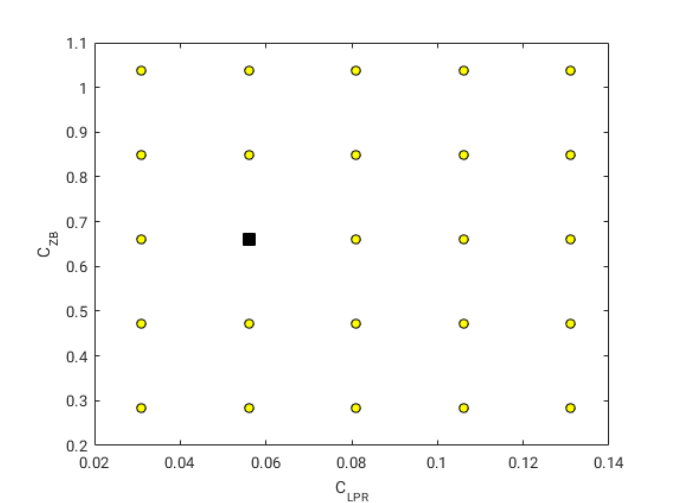
Figure 11. Sampling plan used in this study. The square represents the original geometry, whereas the circles represent the different geometry variations. Every point in the sampling plan represents a location where a high-fidelity computation was computed. All the simulations were conducted at a Froude number of